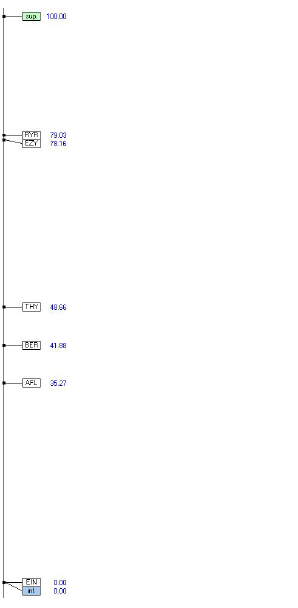
Figure 9: Global Thermometer: Trans- portation.